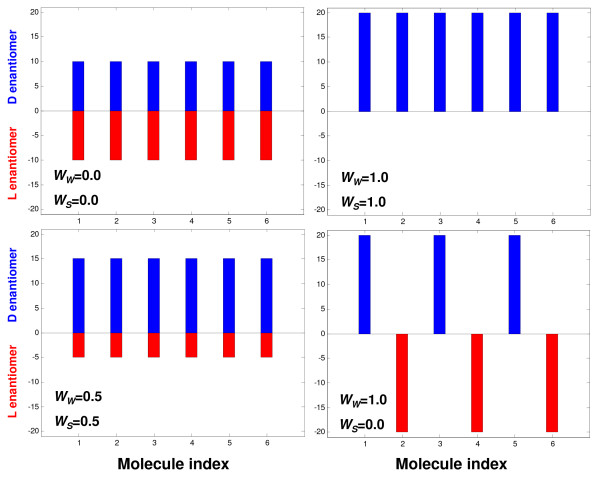
Schematic illustrations of compositions giving rise to different values of WW and WS (Eqs. 6 and 7). In these illustrations Nmax = 120 and NG = 6. Figure details are as Figure 8.